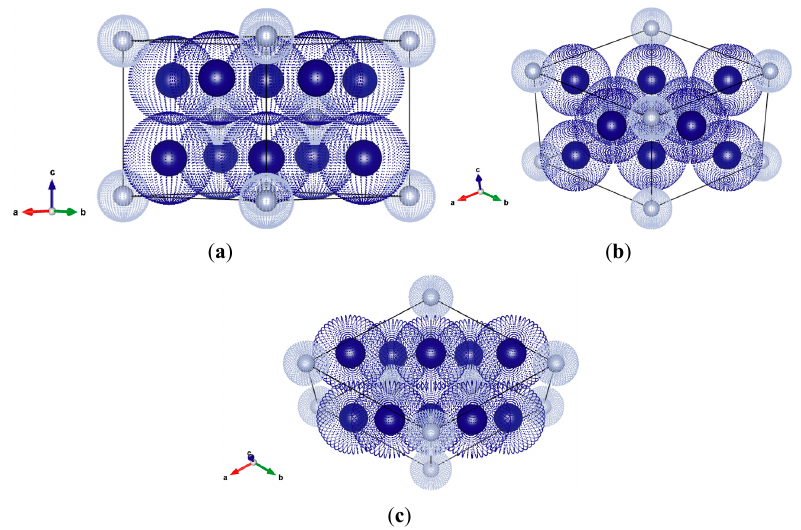
Figure 6. Crystal model of (110) ( a ), (111) ( b ), and (113) ( c ) planes of Cr 2 N. Blue atoms: Cr, gray atoms: N. The diffusion direction is perpendicular to the image plane.